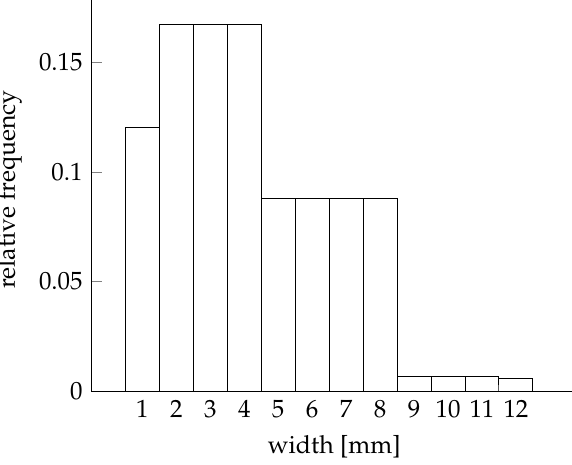
Figure 3. Histogram for the distribution of the width of the wood